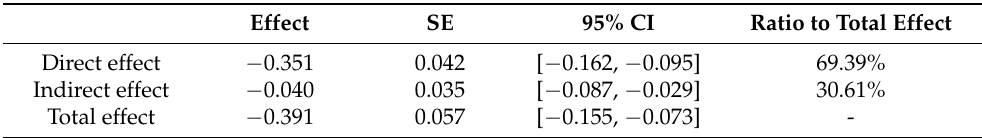
Table 6. Bootstrapping analysis of the mediation